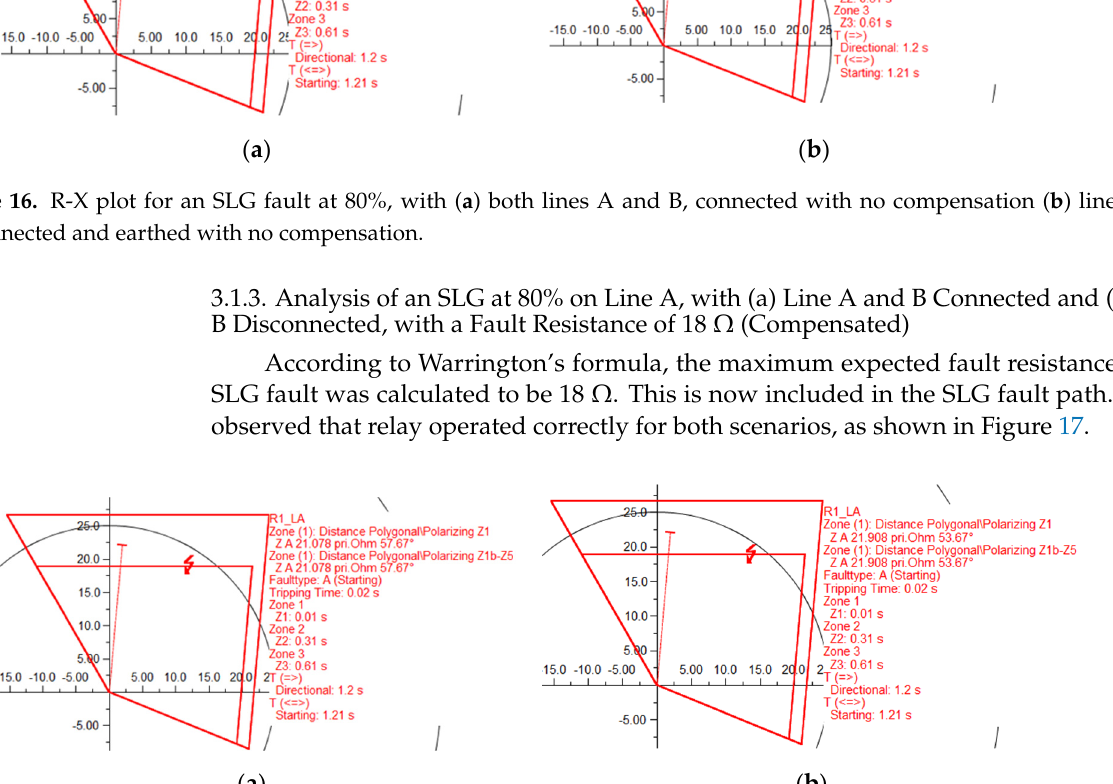
Figure 16. R-X plot for an SLG fault at 80%, with ( a ) both lines A and B, connected with no compensation ( b ) line B dis- connected and earthed with no compensation.